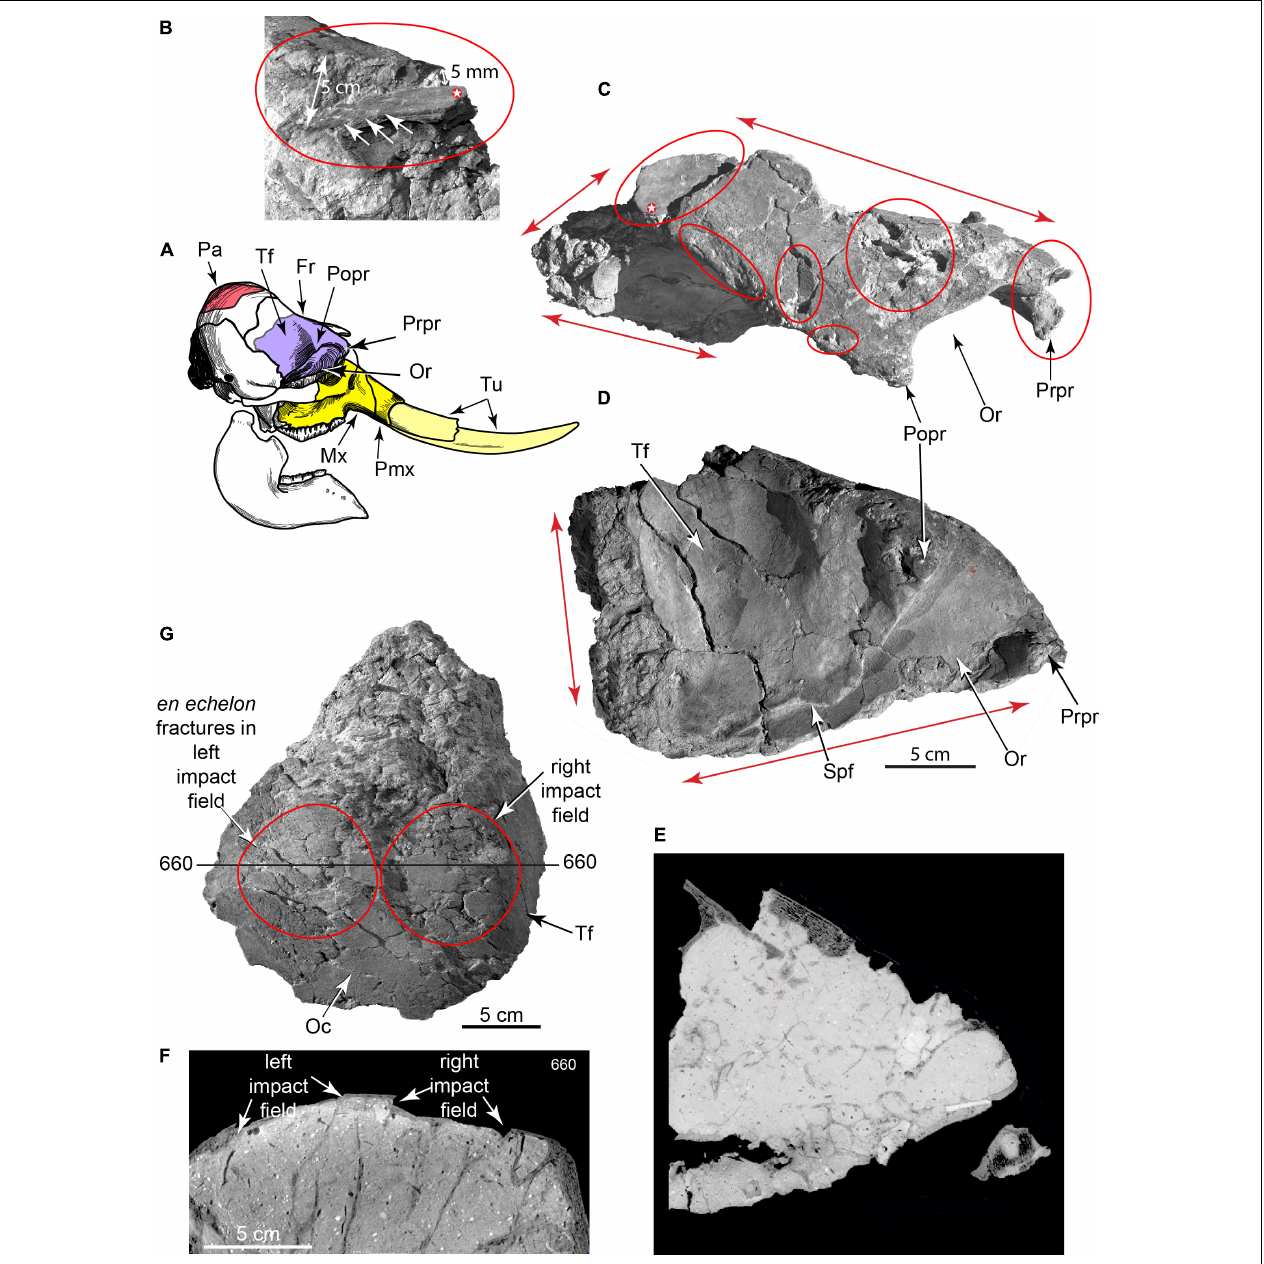
FIGURE 7 | 3D CT volumetric models and cross-sections of broken adult right frontal and right parietal. (A) Key to skull elements. (B–D) Partial right frontal in (B) , caudal (C) , dorsal and lateral views (D) , showing major fracture planes (red arrows F1, F2, F3, F4) where it was sheared from cranium (TMM 47004-1.31; Supplementary Video 6 ). Blunt-force impact wounds (Bfw 1, Bfw 2, Bfw 3), puncture wound concentrations (P1, P2), and two small-gauge punctures into orbital wall from obliquely above (P3, P4). (E) CT slice through frontal showing cemented grains in puncture channel P3 (red arrows), and offset bone from blunt force impact (Bfw 1). (F) CT slice through parietal showing impact-depressed bone (white arrows) and broken underlying trabeculae. (G) Broken right parietal dome showing right and left impact fields on dorsal surface (TMM 47004-1.213). Fr, frontal; Mx, maxilla; Oc, occipital surface of parietal; Or, orbit; Pa, parietal; Pmx, premaxilla; Popr, postorbital process; Prpr, preorbital process; Spf, sphenorbital fissure; Tf, temporal fossa; Tu,